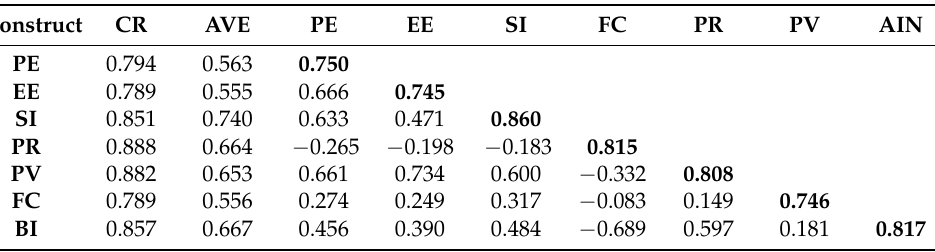
Table 4. CR, AVE, and